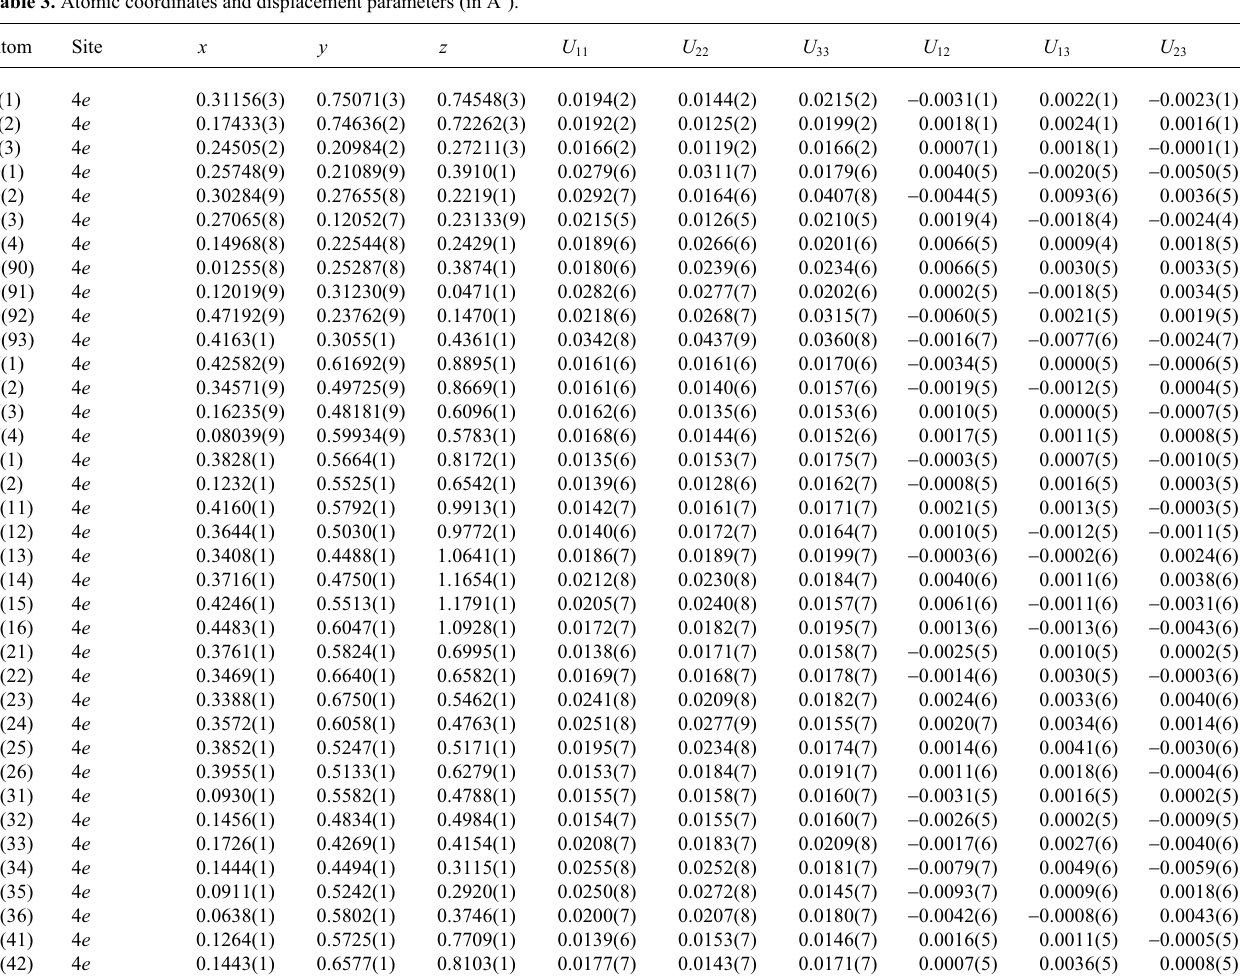
Table 3. Atomic coordinates and displacement parameters (in Å 2 ).